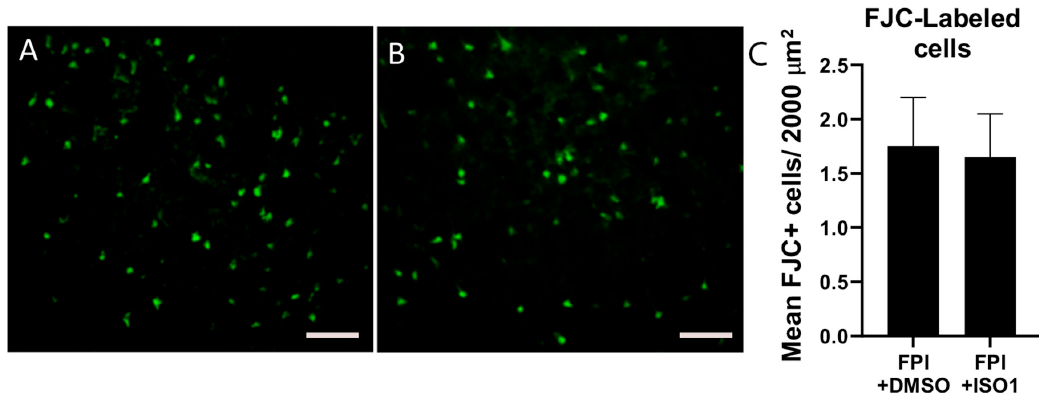
Figure 2. ISO1 has no effect on neurodegeneration at 3 days after FPI. We performed Fluorojade C (FJC) histological staining at 3-days after FPI. In ( A ), FJC-staining in peri-lesion cortex at 3 days after FPI + DMSO. In ( B ), FJC-staining in FPI + ISO mice also reveals robust numbers of degenerating cells. In ( C ), the graph of the means shows that ISO1 had no significant effect on the number of FJC-labeled cells after FPI. This is interesting because we had previously shown that antagonizing the cleaved form of CD74, CLIP, was neuroprotective after FPI. Therefore, is appears as though inhibiting full-length CD74 signaling via MIF antagonism with ISO1 is not neuroprotective, whereas antagonizing a cleaved form of CD74 is neuroprotective. Scale bars = 100 µm.